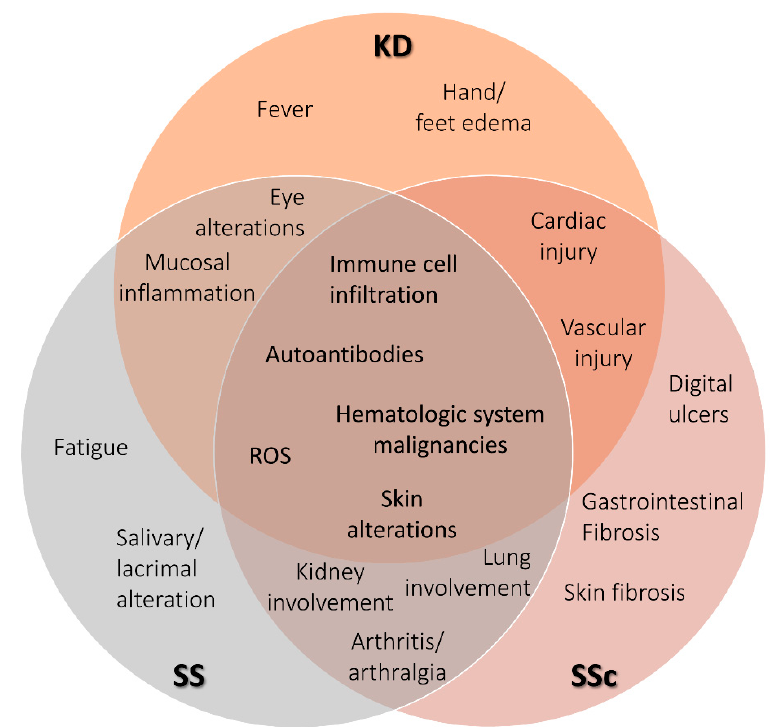
Figure 1. Venn diagram showing phenotypic characteristics of SS, KD, and SSc. Terms shown in the diagram are keywords defining clinical and molecular features characteristic of each rare autoimmune disease. The overlapping sections shows terms shared by the respective disease. Kawasaki disease (KD), Sjögren’s syndrome (SS), and systemic sclerosis (SSc). Sjögren’s syndrome (SS; MIM: 270150 and ORPHA: 289390) is a rare chronic